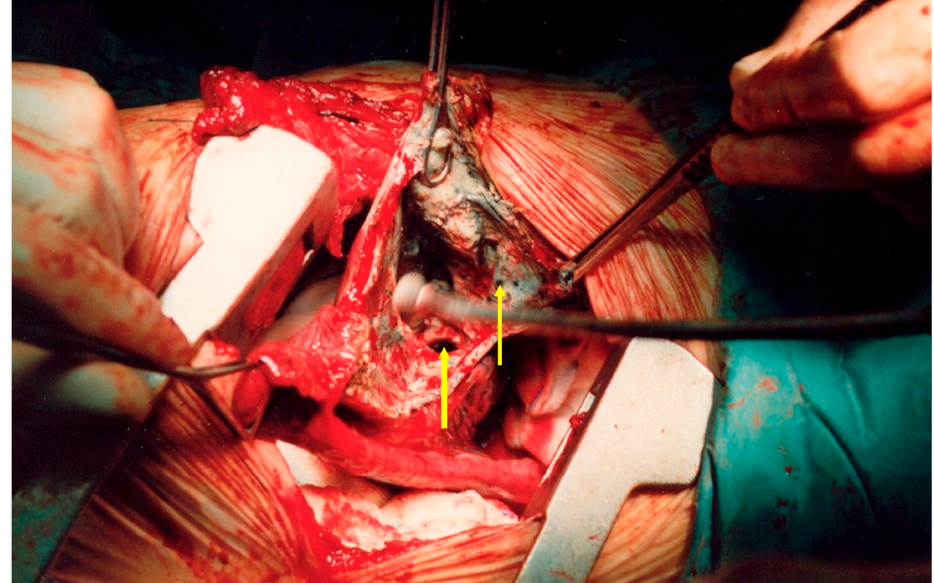
Figure 11. An intraoperative image of patient 3. Extensive dissection is required to remove the echinoccocal lesion and the surrounding necrotic tissue, leaving a raw parenchyma and frequently open segmental and subsegmental bronchi. Bronchial openings (yellow arrows) must be ligated for aerostasis. Endostaplers are not advised for this situation. We advise the use of absorbable sutures to ligate open ends and approximate raw surfaces.